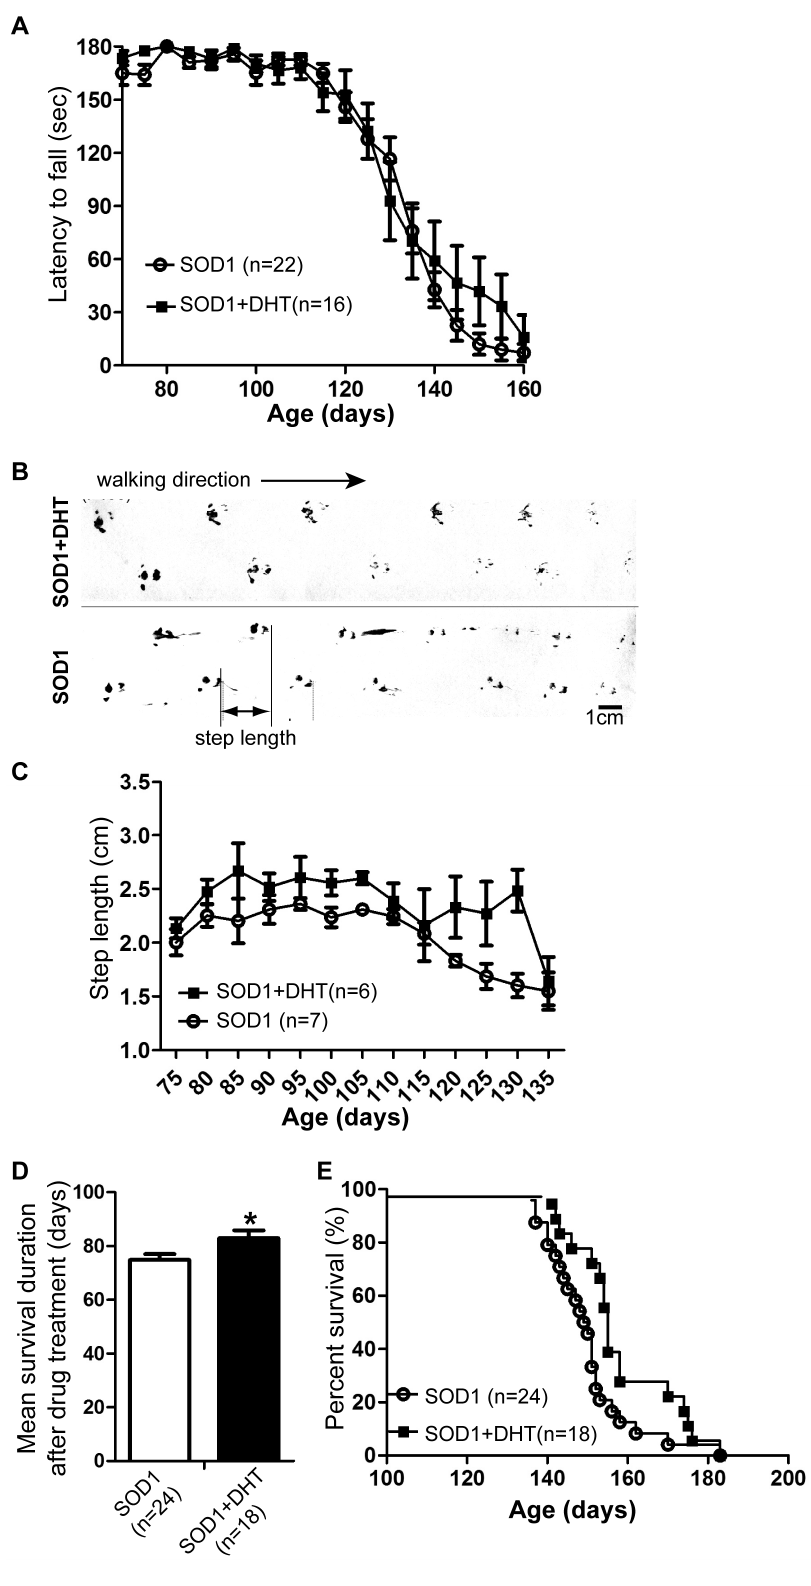
Figure 8. DHT improves motor performances and survival in SOD1 mice. A: SOD1 mice were implanted with either a DHT-filled or an empty silastic (control) tube at P75, and their motor performances were assessed every 5 days by the rota-rod test. A mouse was placed on the rotating rod at 11 rpm, and the latency until the mouse fell from the rotating rod was recorded in seconds. DHT-treated SOD1 mice (filled square, n=16) stayed longer on the rotating rod compared with control SOD1 mice (empty circle, n=22). Data are mean 6 SEM. p =0.043 (2-way ANOVA). B: Hindlimbs